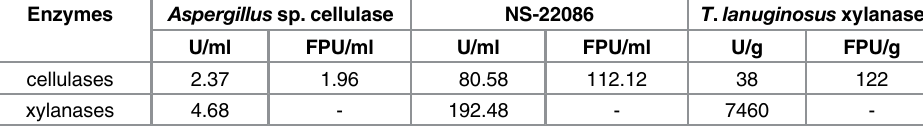
Table 1. Activities of cellulases and xylanases (at 50°C and pH 5.0) of the three tested enzyme preparations.